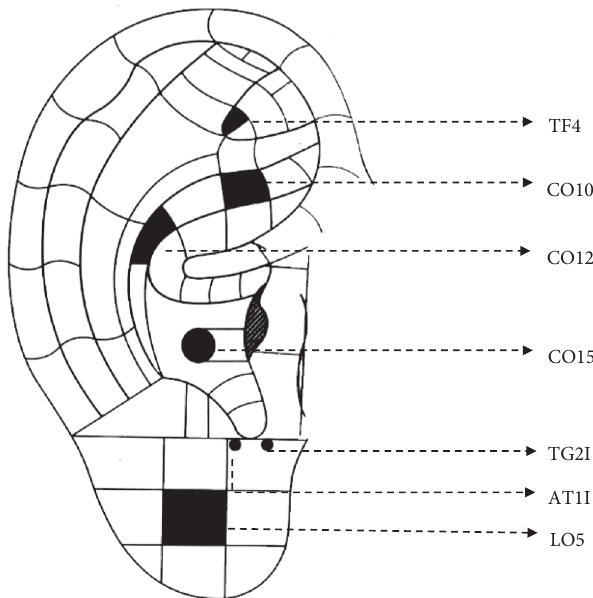
Figure 1: Selected auricular points for preventing myopia. This picture was modified according to the auricular map issued by the World Federation of Acupuncture-Moxibustion Societies